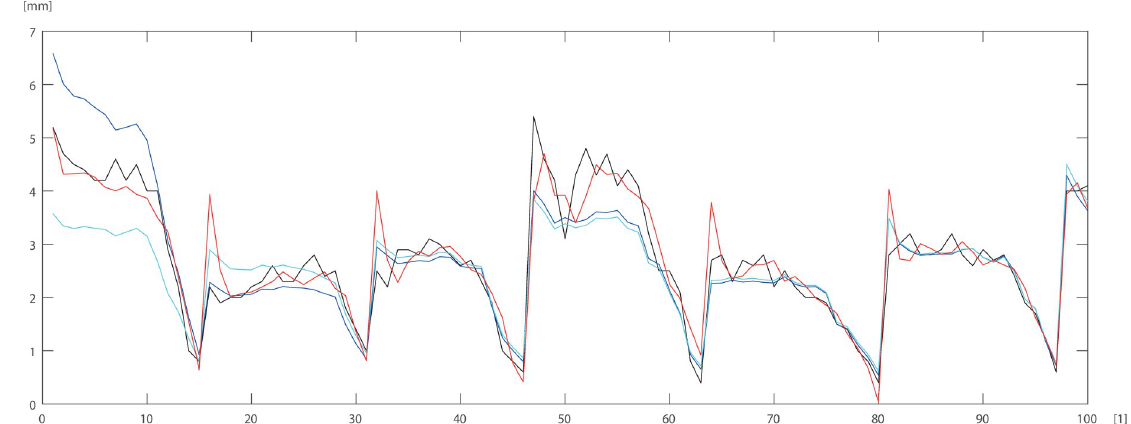
Fig 4. Results of simulation for 2(1)-20–1 networked trained with BR for pine data, where horizontal axis [1]—identifier of measurement.